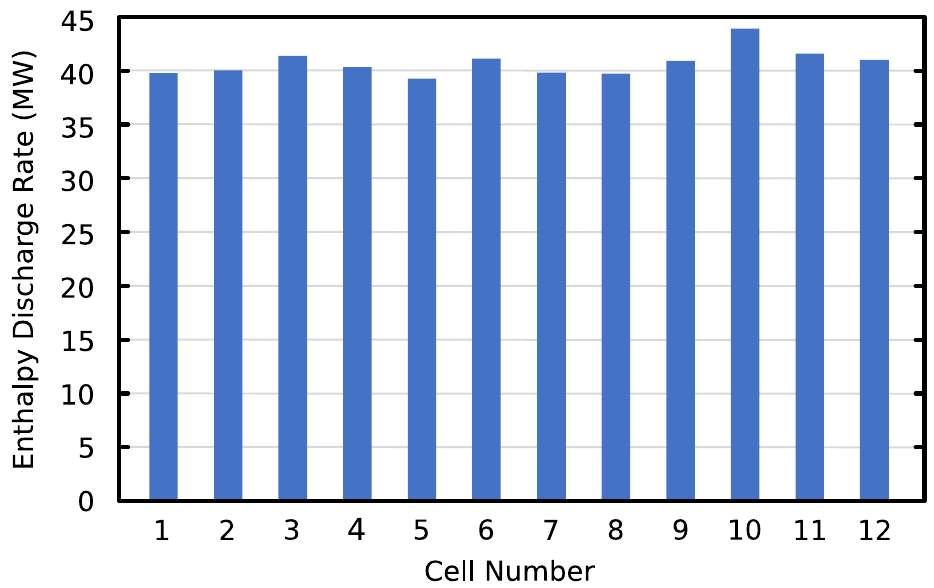
Figure 4. Average enthalpy transfer rates for the twelve cells that were computed with the 5 min exhaust air temperatures, regional meteorological data, and basic cooling tower data.